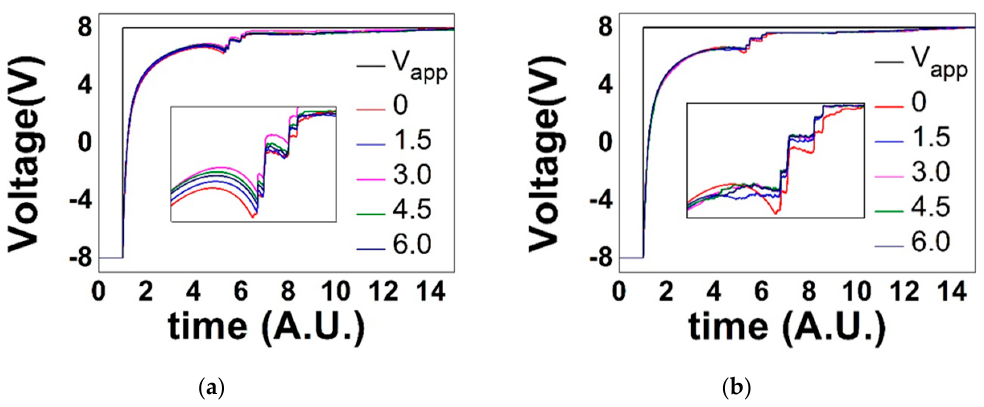
Figure 7. Simulated transient NC of the R-FEC circuit with the interface trap: ( a ) positive interface trap, ( b ) negative interface charge. The interface trap density is neutral, 1.4 × 10 12 , 2.8 × 10 12 , 4.2 × 10 12 , 5.6 × 10 12 e/cm2 (0, 1.5, 3.0, 4.5, 6.0, respectively).